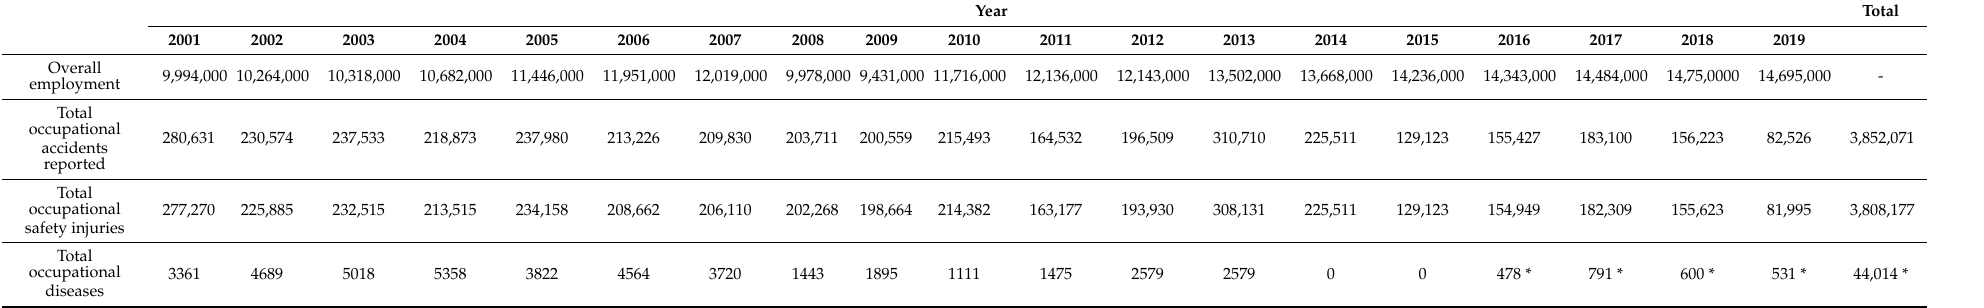
Table A2. Employment, total accidents, injuries and occupational diseases, 2001-2019 in South African